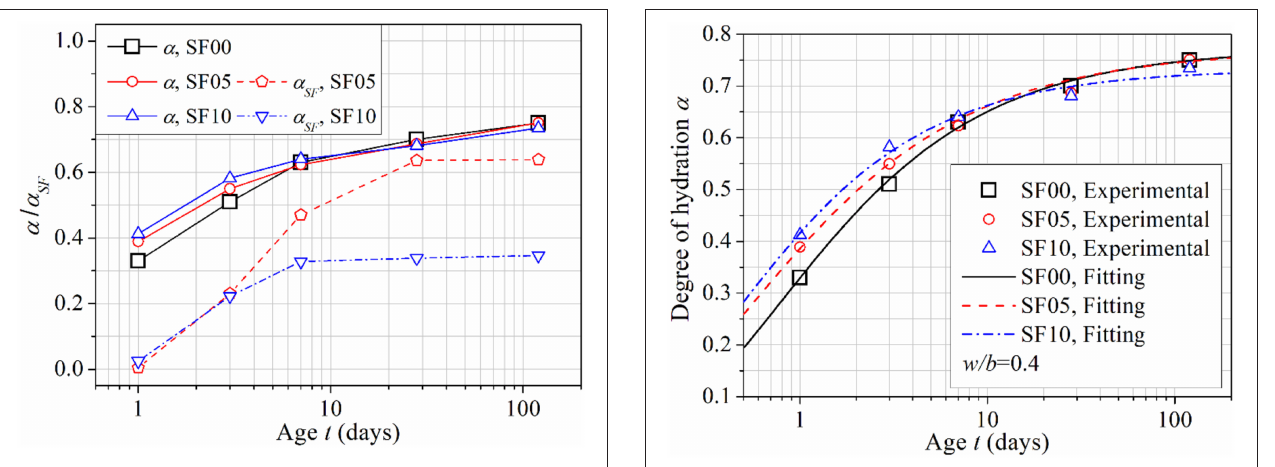
FIGURE 8 | Nonlinear fitting of hydration degree of cement ( α ) in blended pastes.